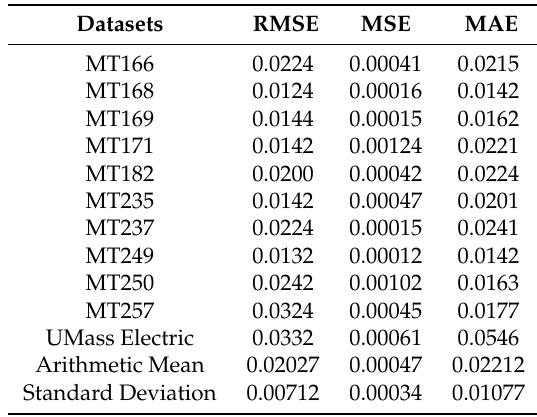
Table 23. Accuracy of ERELM using RMSE, MSE and MAE for yearly